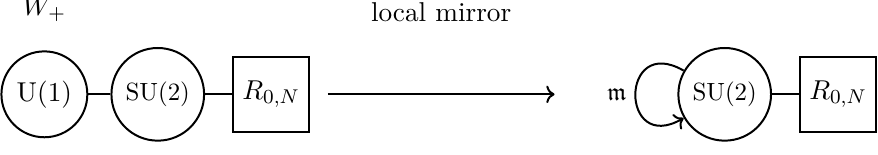
Figure 2 . Effective theory of a single quiver node after monopole